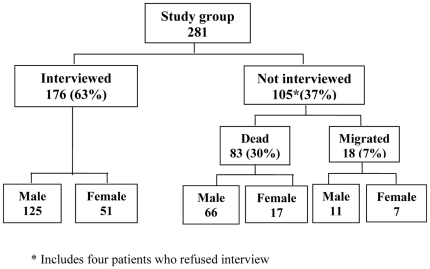
Interview coverage of the study group.